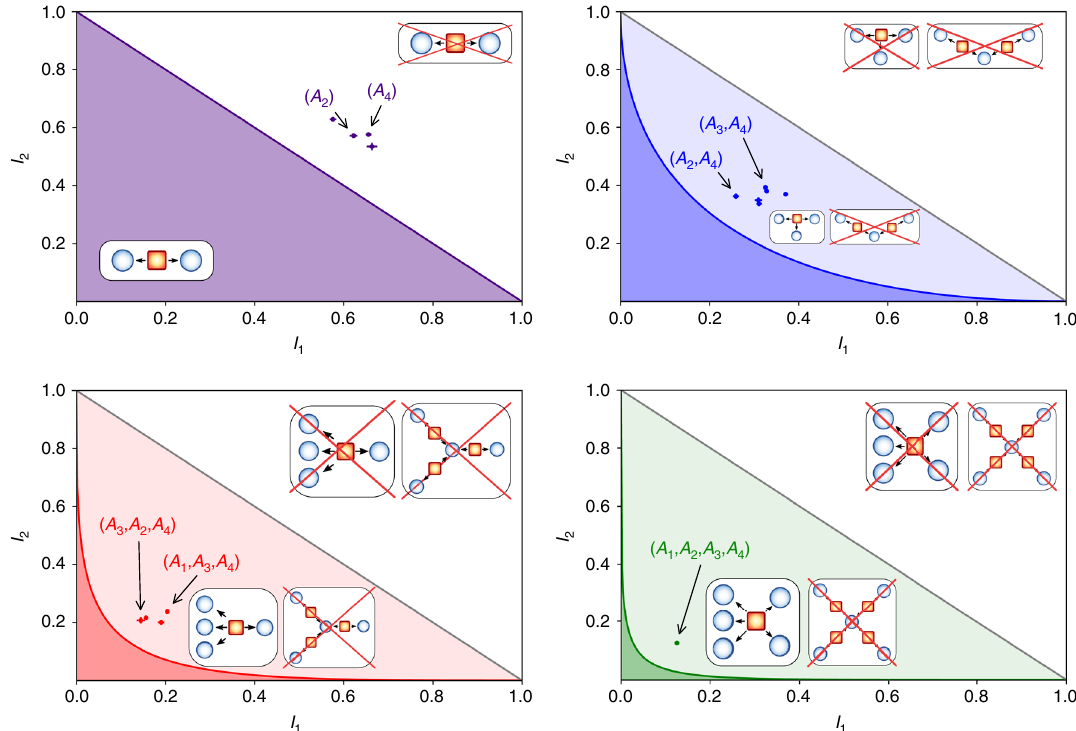
Fig. 3 Experimental correlations represented in the I 1 , I 2 plane ( k = 2 settings). The purple, blue, red, and green regions represent the classical correlations for 1-, 2-, 3-, and 4-local scenarios, respectively. The 2-local case corresponds to the bilocal inequality while the 1-local reduces to the paradigmatic CHSH inequality. For n ≥ 2, the gray line bounds the correlations allowed by a local model with no assumption on sources independence. The green point represents the I 1 , I 2 values measured in the case of n = 4 sources. The red, blue, and purple points represent the experimental values for all the possible combination of laboratories which are 4, 6, and 4 in the 3-, 2-, and 1-star cases, respectively. Error bars represent the standard error of the mean taken over different sequential